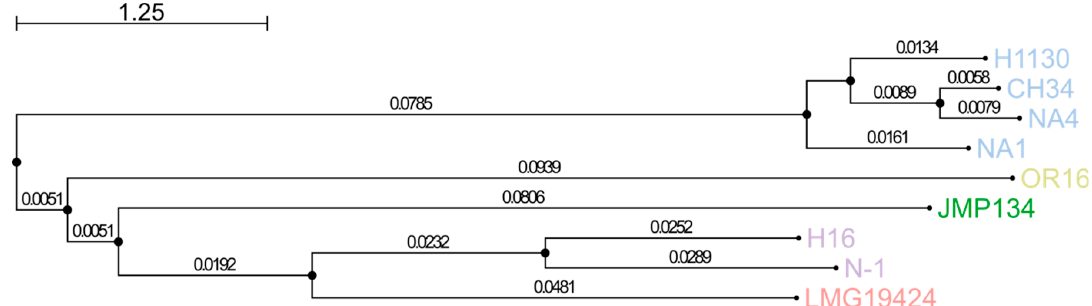
Figure 3. Venn diagram displaying the distribution of shared MicroScope gene families (MICFAM) among C. metallidurans CH34, NA1, NA4 and H1130.